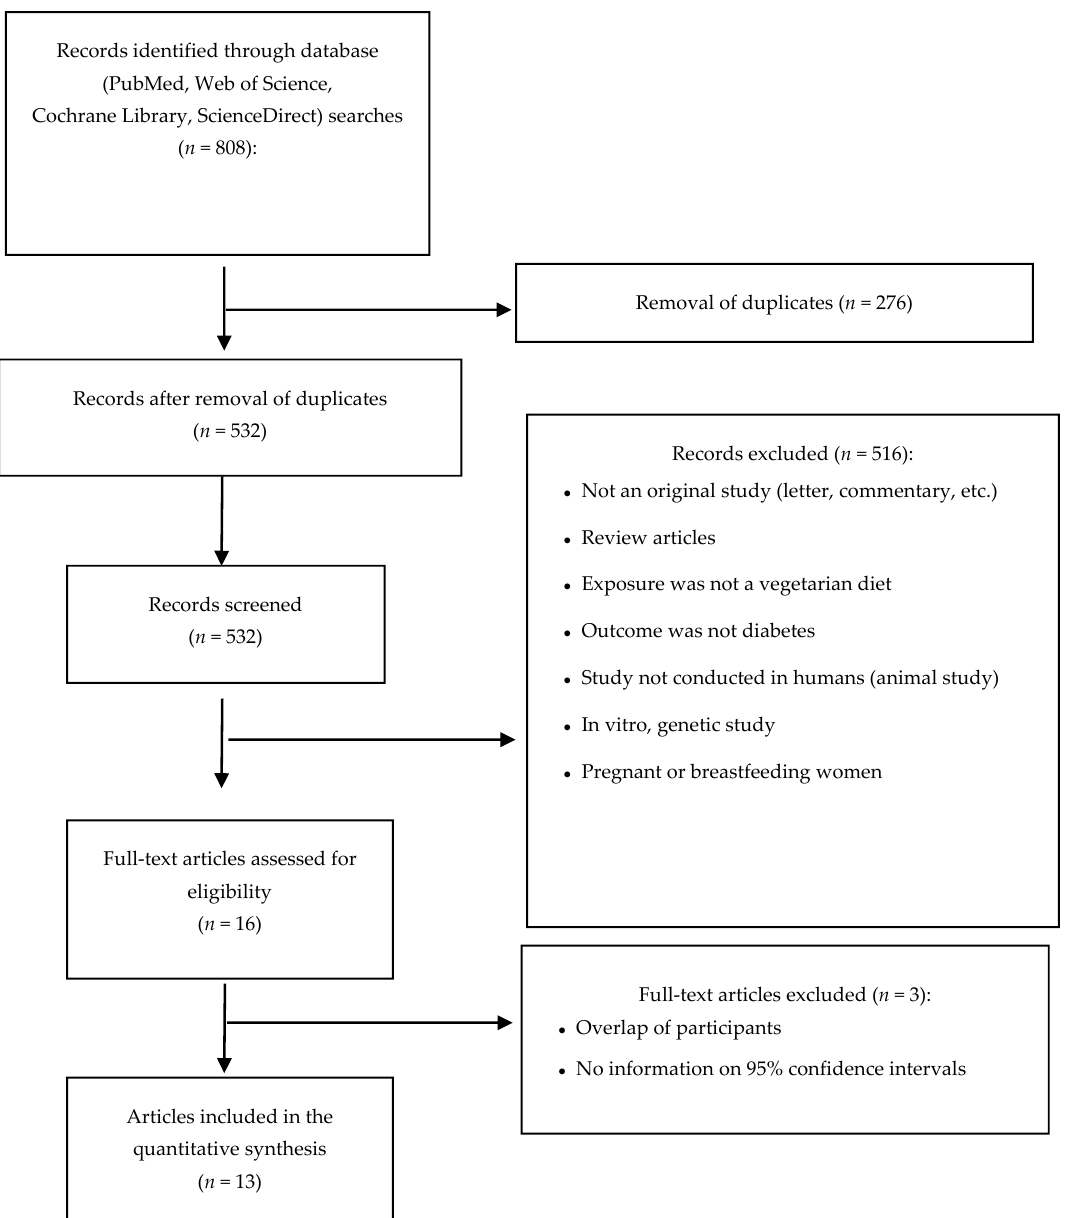
Figure 1. Flow diagram of study selection.